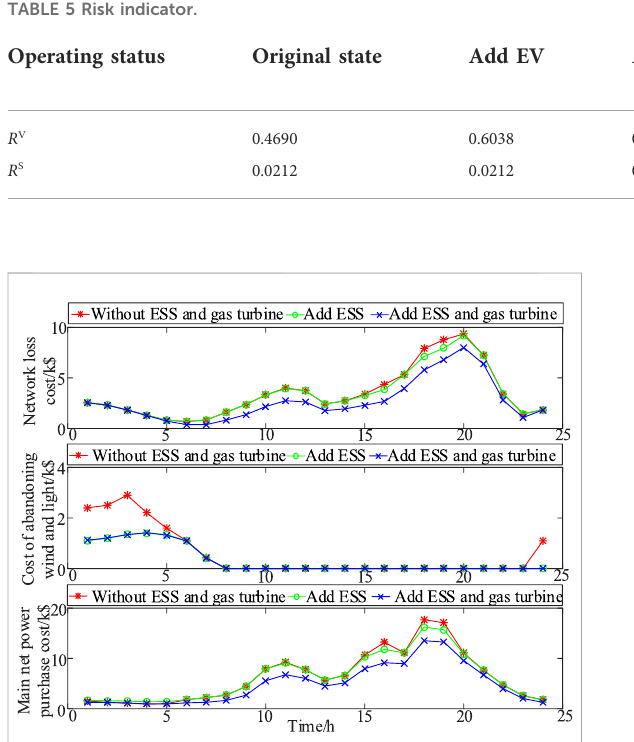
FIGURE 7 Carbon dioxide emission